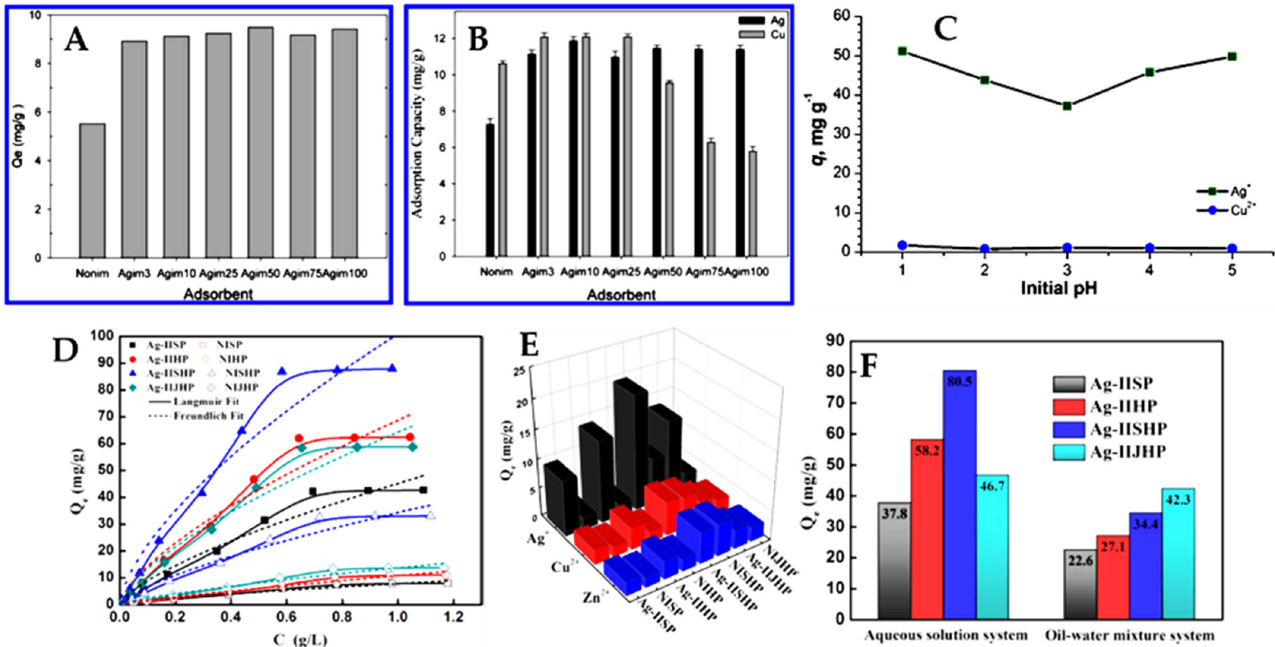
Figure 17. ( A ) Ag(I) sorption capacity of CS hydrogels with different imprinting ratios (Nonim = non- imprinted hydrogels; Agim3 to Agim100 = hydrogels with different Ag(I) imprinting mass ratios). (Reproduced with permission from Ref. [170]. Copyright 2012 American Chemical Society) ( B ) Com- petitive adsorption of Ag(I) and Cu(II) by Ag(I)-imprinted CS hydrogels with different imprinting ratios. (Reproduced with permission from Ref. [170]. Copyright 2012 American Chemical Society) ( C ) The effect of pH on Ag(I) and Cu(II) ions sorption by Ag(I)-imprinted CS gel beads. (Repro- duced with permission from Ref. [171]. Copyright 2015 Elsevier) ( D ) Ag(I) sorption isotherms (with Langmuir and Freundlich models fitting profiles) by Ag(I)-imprinted and non-imprinted CS- P(DVB-glycidyl methacrylate (GMA)-ST) particles. (Reproduced with permission from Ref. [172]. Copyright 2015 American Chemical Society) ( E ) Selectivity of Ag(I) sorption by Ag(I)-imprinted and non-imprinted CS-P(DVB-GMA-ST) particles. (Reproduced with permission from Ref. [172]. Copyright 2015 American Chemical Society) ( F ) The effect of morphology on Ag(I) sorption by Ag(I)- imprinted CS-P(DVB-GMA-ST) particles. (Reproduced with permission from Ref. [172]. Copyright 2015 American Chemical